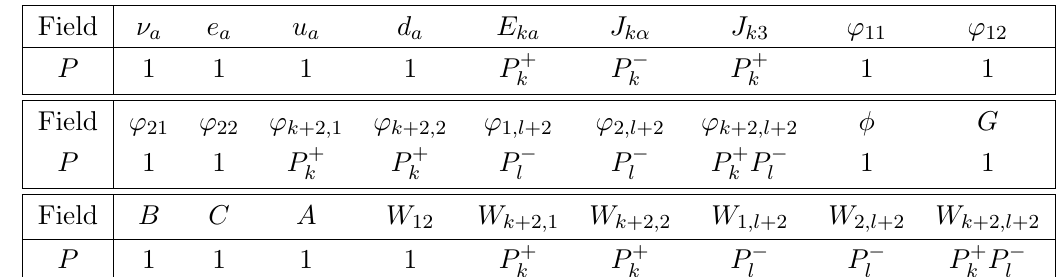
( 1) (cid:6) (3 n k;l +1) k;l (cid:17) (cid:0)